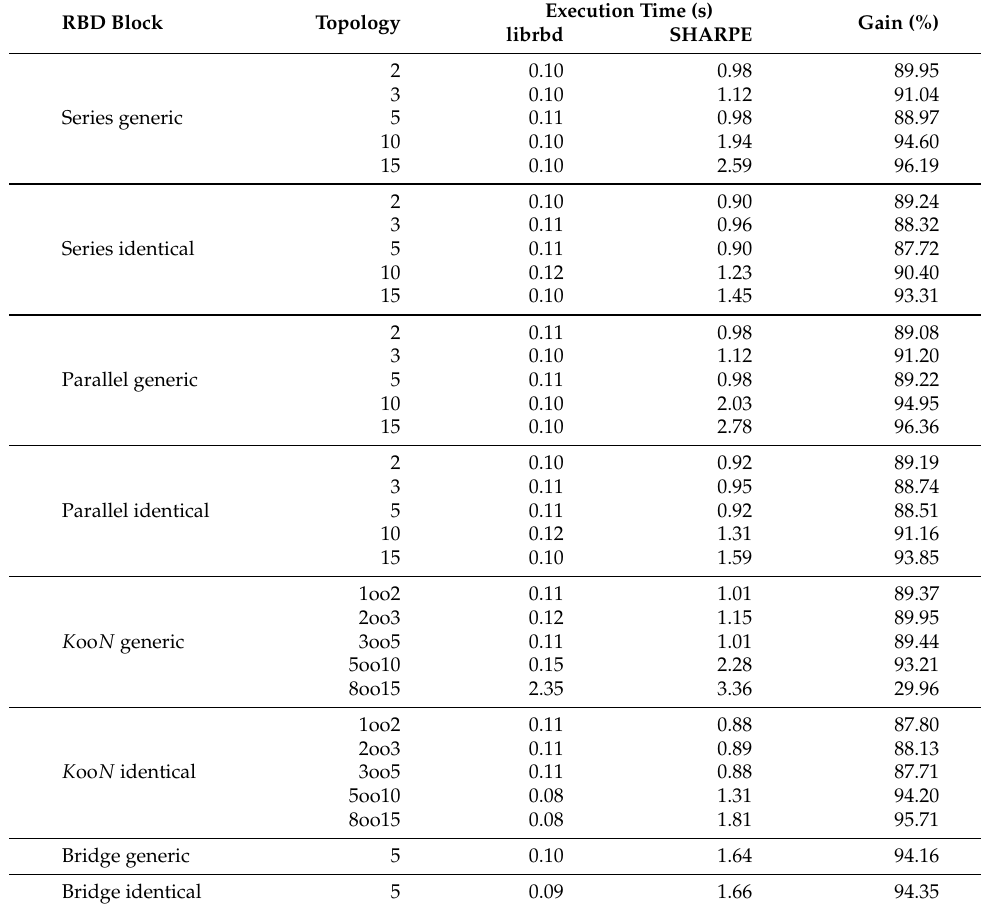
Table 15. Execution time